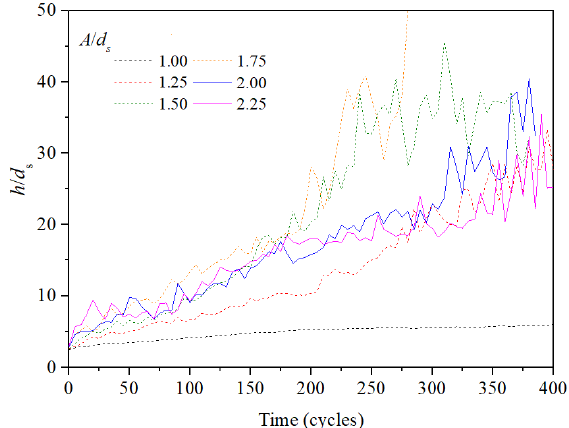
Figure 3. The vertical position of the intruder in the ascending process under different vibration amplitudes. d Sau = 6 mm, f = 20 Hz, d l / d s = 3.0.